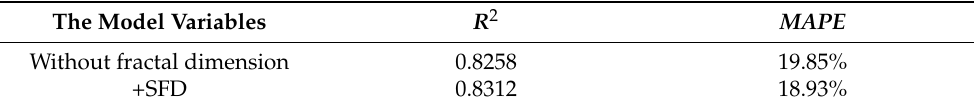
Table 7. R 2 and MAPE for the plant height model.